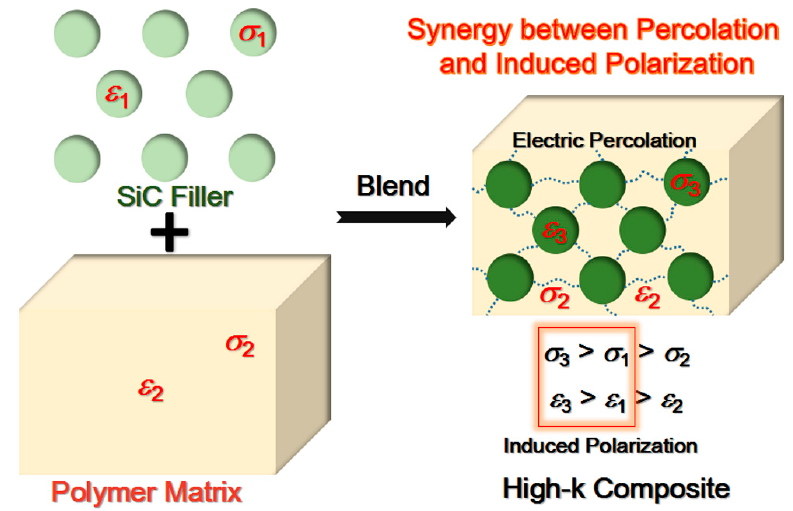
Figure 8. Schematic diagram for physical blend of SiC and polymer showed hypothetical synergy effect between electric percolation and interface induced polarization, contributing to high-k property achieved in the present nanocomposite systems.